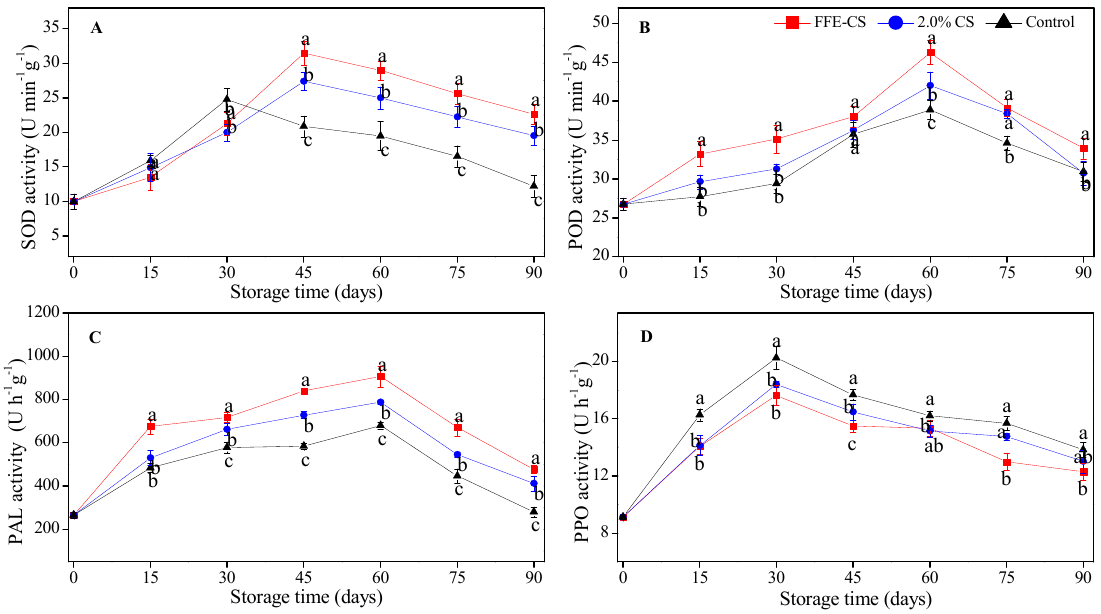
Figure 6. Effect of FFE–CS coating on the activities of superoxide dismutase (SOD) ( A ), peroxidase (POD) ( B ), polyphenol oxidase (PPO) ( C ), and phenylalanine ammonia-lyase (PAL) ( D ) of Xinyu tangerines during cold storage of 90 days. Differences between treatments for each time were analyzed using Duncan’s multiple range test at P < 0.05.